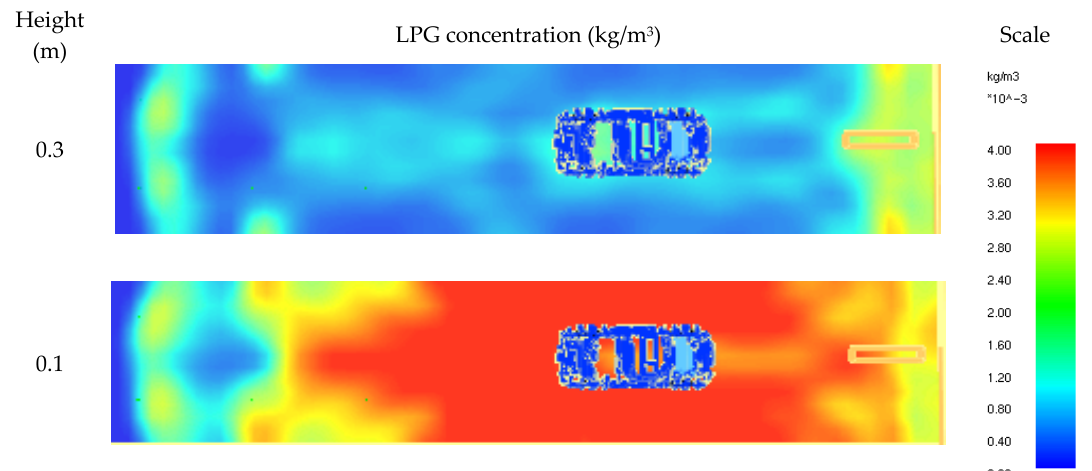
Figure 15. CFD results—LPG gas concentration at the height of 0.3 m and 0.1 m.